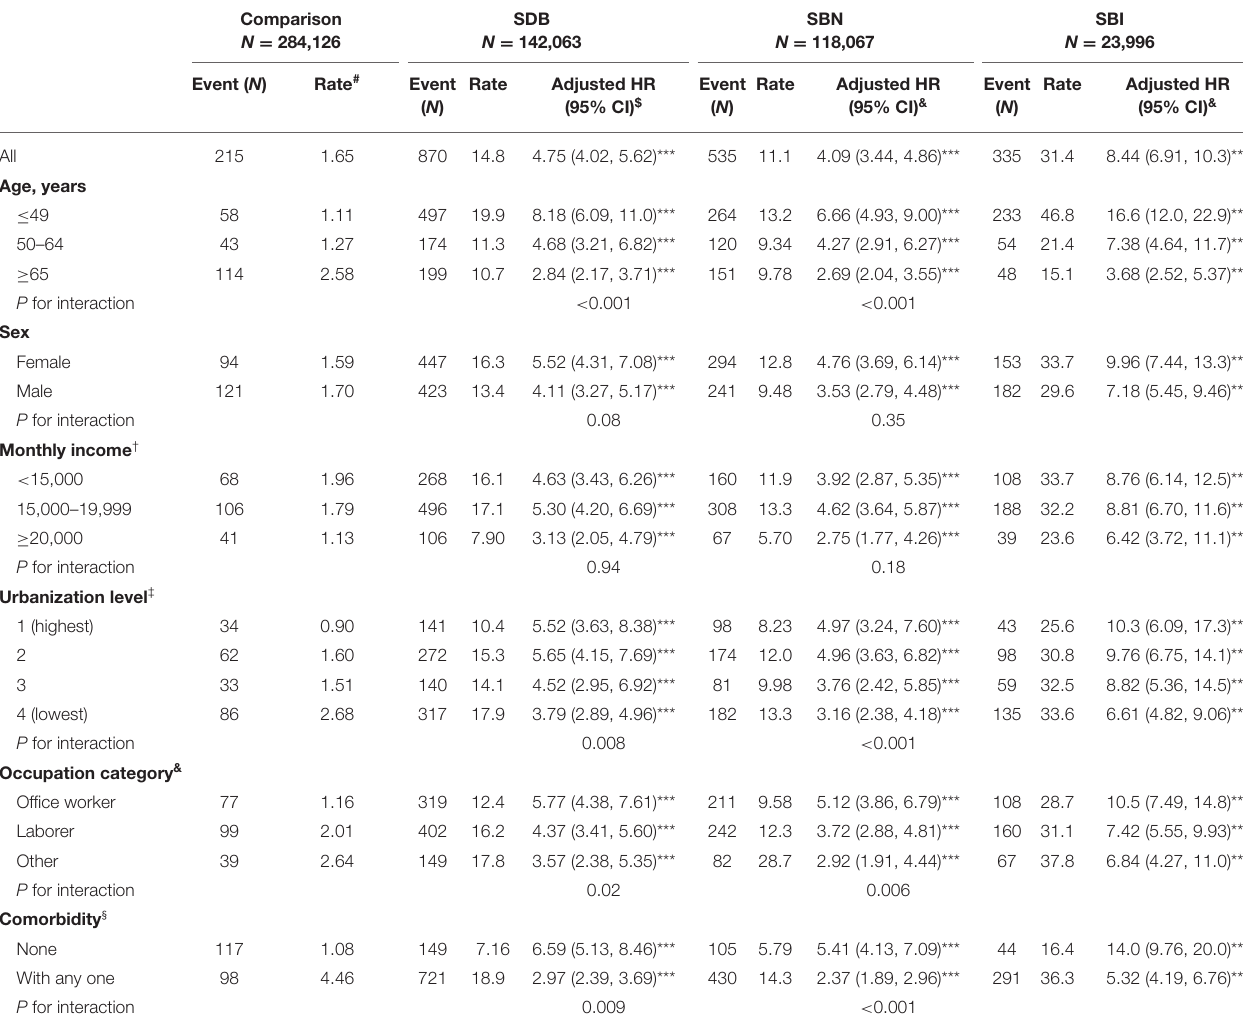
TABLE 2 | Comparison of incidence and hazard ratio for suicide attempt stratified by age, sex, monthly income, urbanization level, occupation, and comorbidity between the SDB, SBN, SBI, and comparison cohorts. Comparison N =